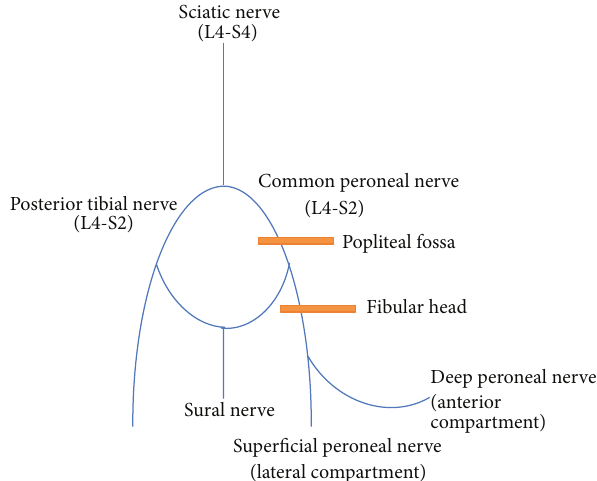
Figure 1: Anatomy of the peroneal nerve. The sciatic nerve branches into the tibial and common peroneal nerves superior to the popliteal fossa. The orange bands represent areas of potential injury to the peroneal nerve. The peroneal nerve is most commonly injured during childbirth from prolonged or forceful external compression to the fibular head while grasping and flexing the knee when pushing in the semi-Fowler-lithotomy position. The superficial location of the peroneal nerve as it courses around the fibular head increases the risk of injury or trauma to the peroneal